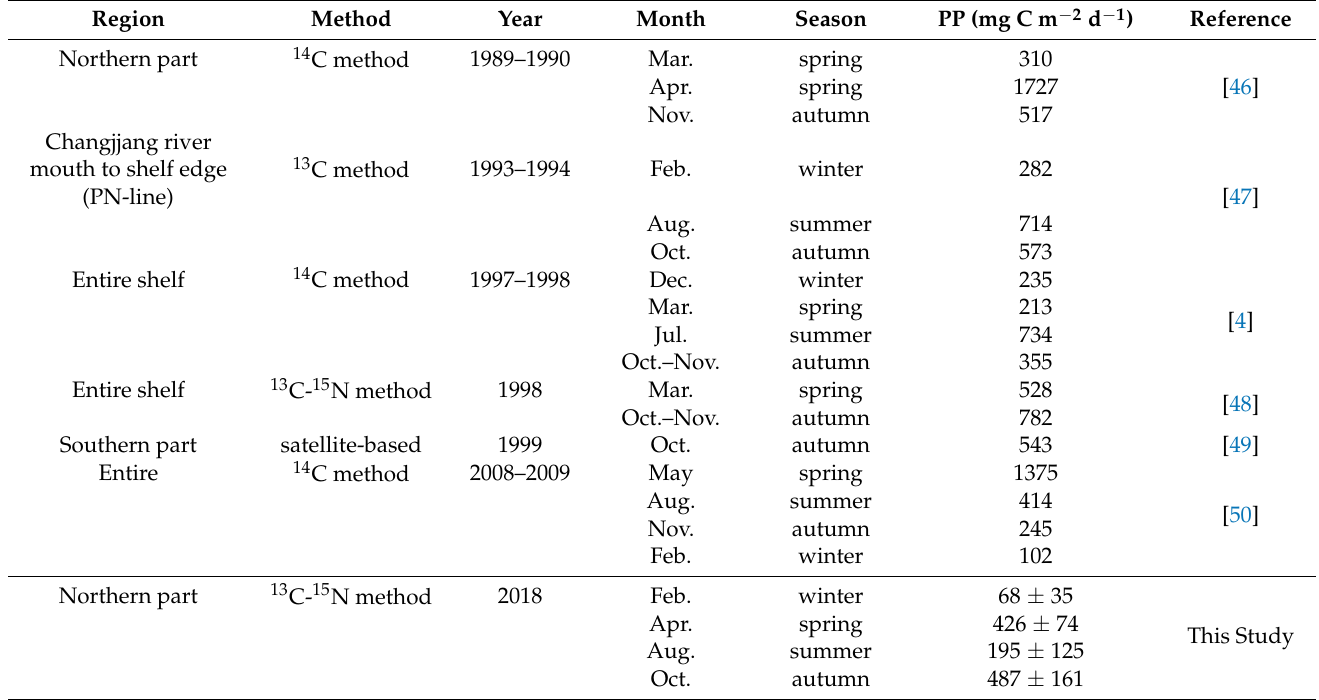
Table 4. Comparisons of daily primary production in the East China Sea. PP represents daily primary